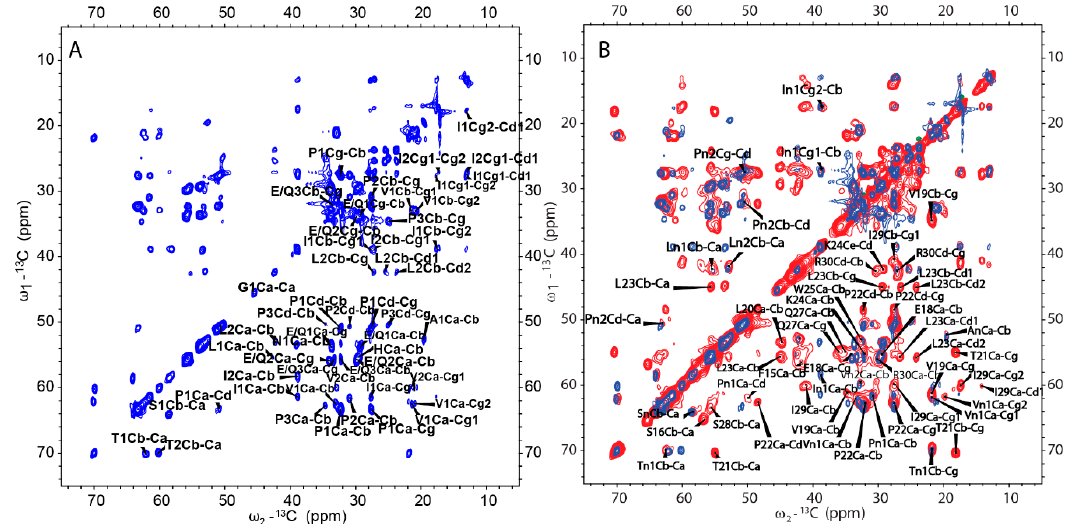
Figure 8. ( A ) 2D 13 C- 13 C INEPT-TOBSY spectrum of H175 assemblies formed at pH 6.0 using uniformly [ 13 C, 15 N]-labeled protein. ( B ) Comparison between 2D DARR spectrum (red) and 2D INEPT-TOBSY spectrum (blue) of H175 assemblies prepared at pH 6.0.